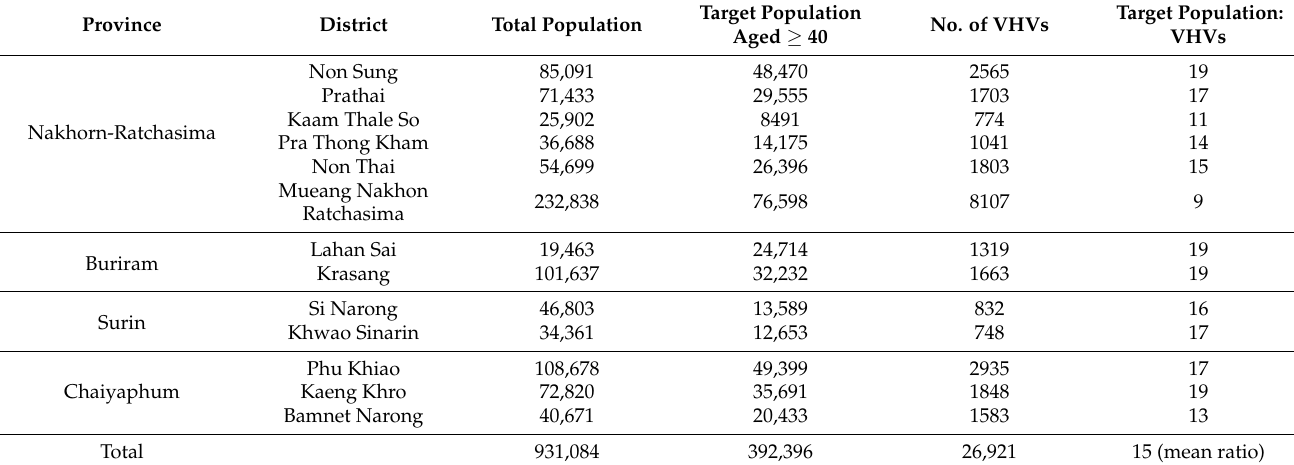
Table 1. Demographics of each district considered for the